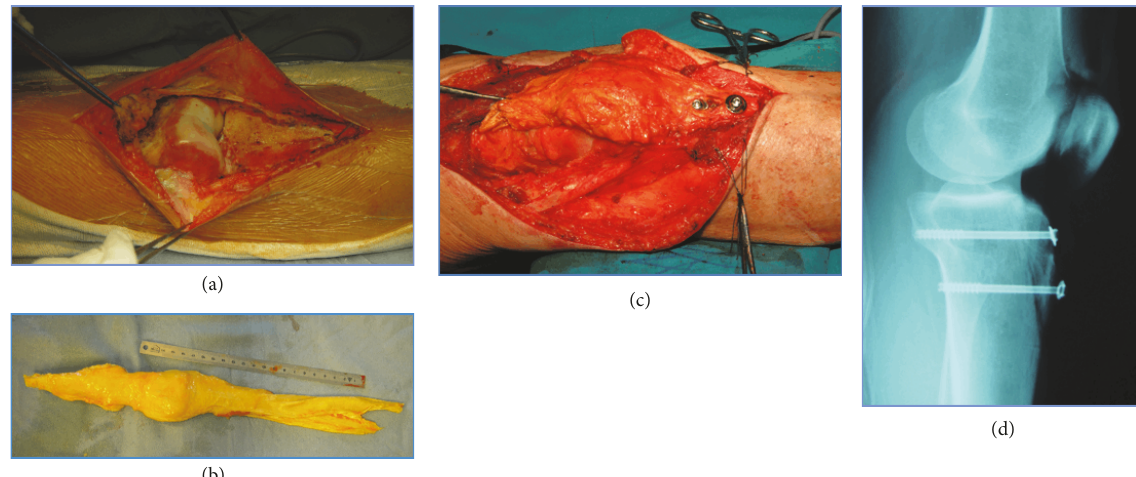
Figure 2: Surgical technique. Clinical case (patient number 4) as example for the surgical technique used in the described study population. (a) Complete resection of lesion and extensor apparatus; (b) preparation of the osteotendinous allograft; (c) fixation of the allograft with screws distally and direct end-to-end suture proximally; (d) postoperative